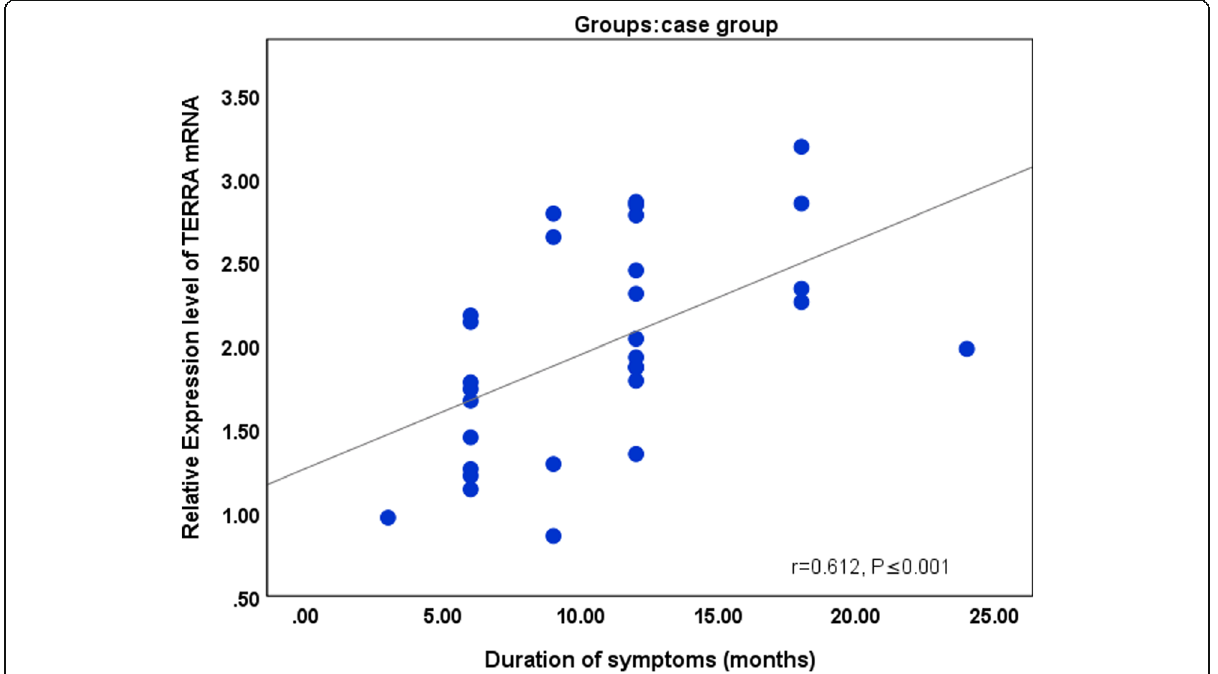
Fig. 6 Scatter diagram showing that both relative expression and predicted forced vital capacity to have a negative correlation